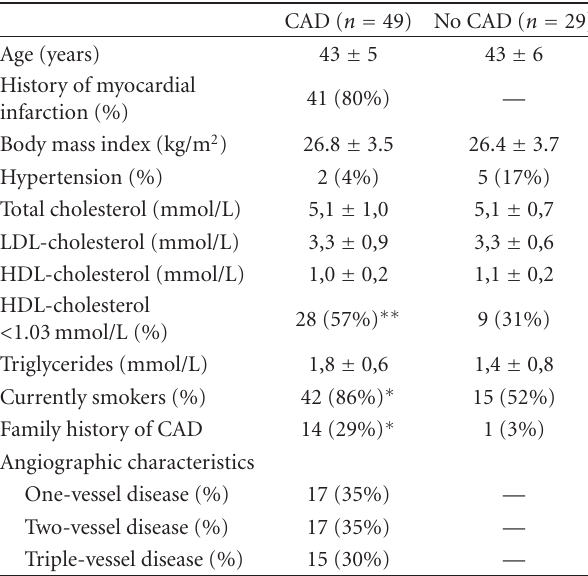
Table 1: Clinical characteristic.